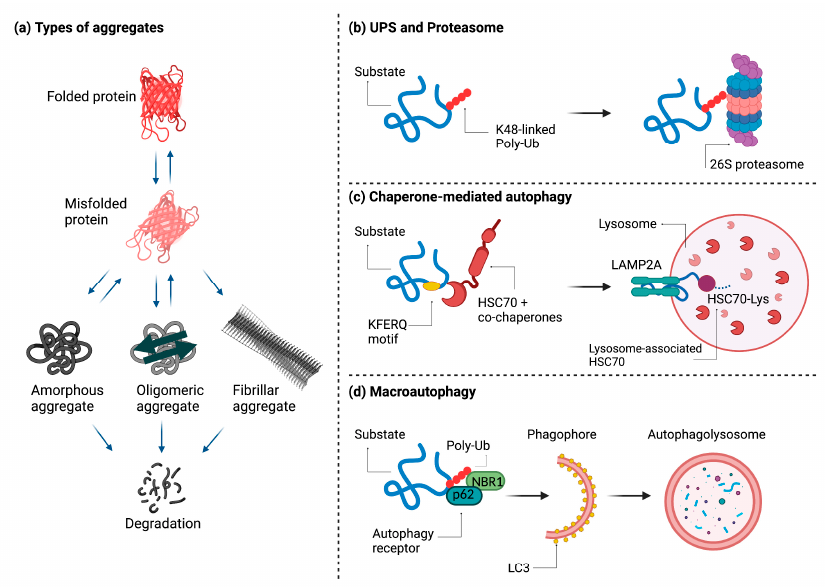
Figure 1. Types of aggregates and degradation mechanisms. A functional protein is normally found in a properly folded three-dimensional state. Aggregation, which is normally prevented by molecular chaperones, can occur as a result of different stimuli and lead to the formation of three different types of aggregates: amorphous, oligomeric, or fibrillar. Except in the case of fibrillar aggregates, these proteins can return to their folded state. If this does not happen, they are degraded ( a ). Aggregates can be degraded in three different ways: by the ubiquitin-proteasome system ( b ), by chaperone- mediated autophagy ( c ), or by aggrephagy, a special form of macroautophagy ( d ). Figure created with BioRender.com (accessed on 3 August